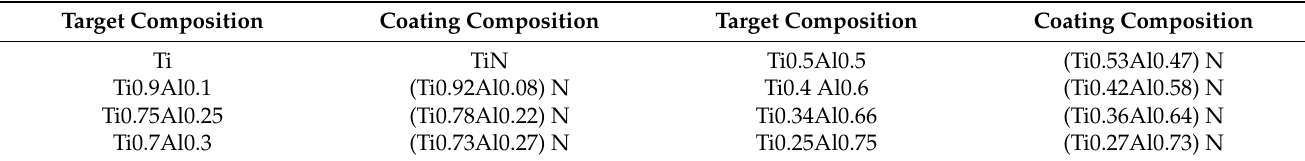
Table 1. Ti and Al ratio of targets and deposited coatings.